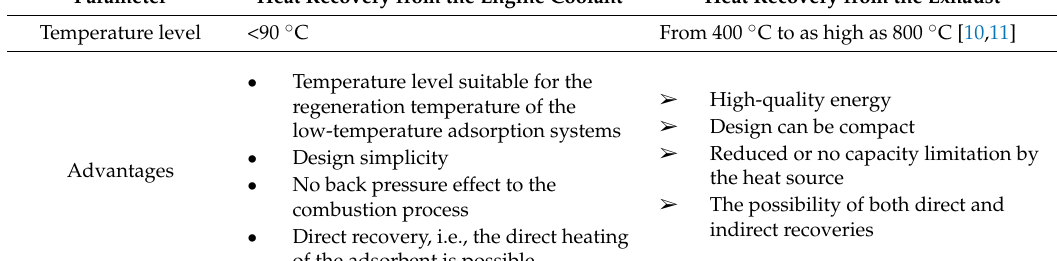
Table 2. Temperature level and the advantages and disadvantages of heat recovery methods from internal combustion (IC) engine of an automobile.